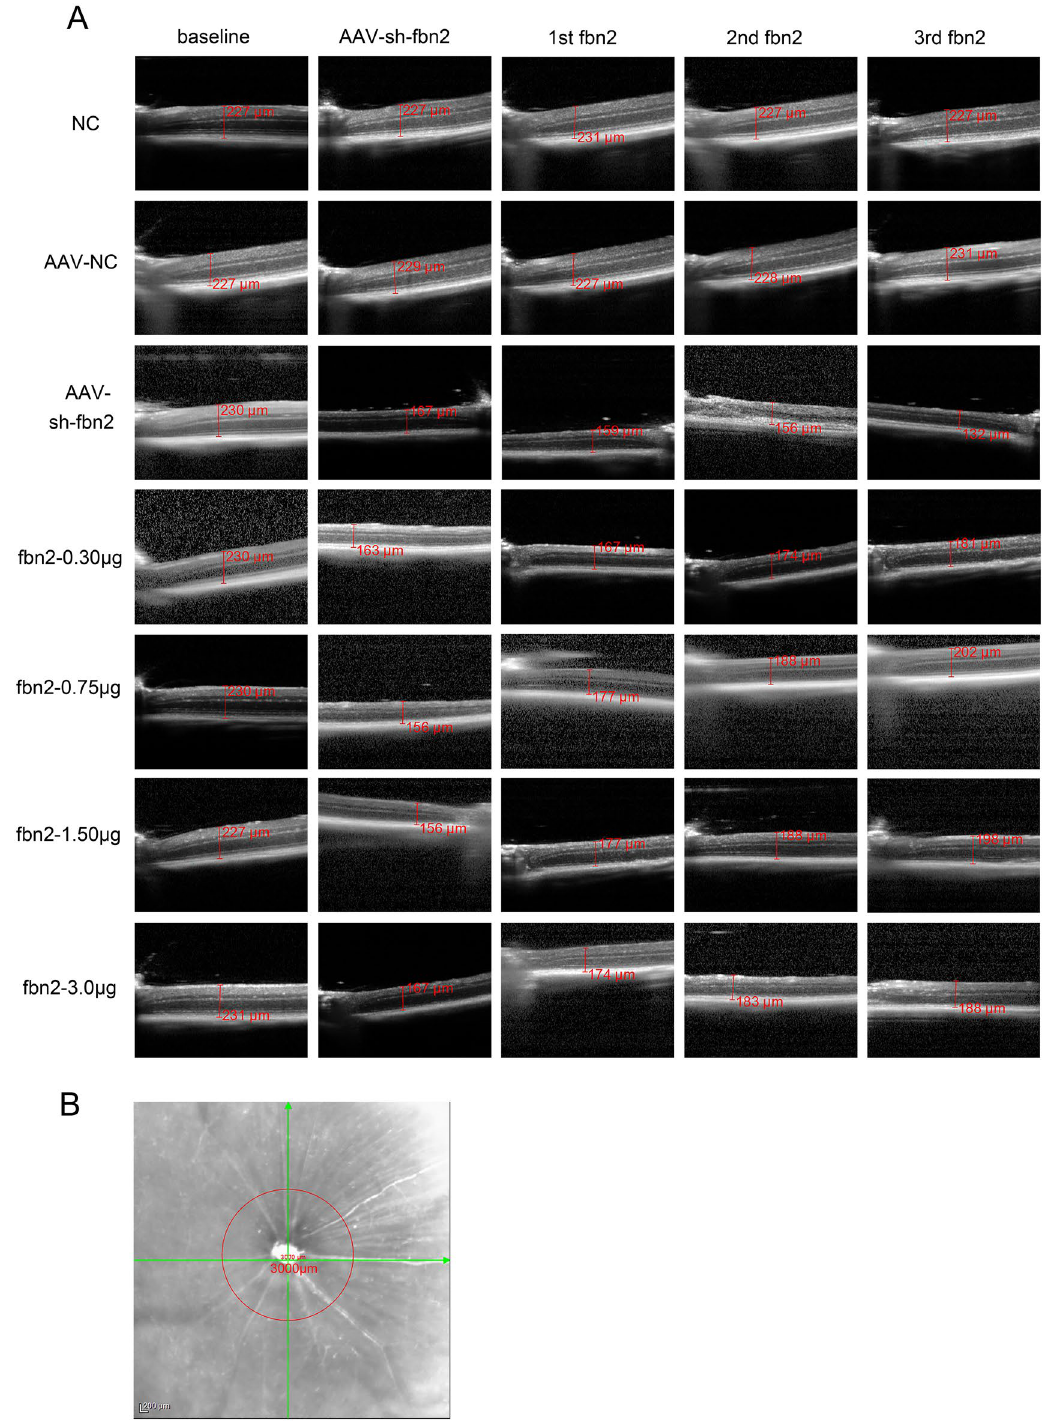
Figure 4. Retinal thickness imaging captured by OCT in NC, AAV-NC, AAV-sh-fbn2, Fbn2-0.30 μg, Fbn2- 0.75 μg, Fbn2-1.50 μg and Fbn2-3.0 μg group mice. ( A ). Retinal thickness was measured at 3000 μm from optic disc (inferior, nasal, temporal, and superior) ( B ).NC group: Animals without intervention. AAV-NC group: Animals with an intravitreal injection of AAV empty vector and without any further treatment. AAV-sh-fbn2 group: Animals with an intravitreal injection of AAV-sh-fbn2 and without any further treatment. Fbn2-0.30 μg group: Animals with an intravitreal injection of AAV-sh-fbn2, followed by an intravitreal injection of fbn2 recombinant protein in a dose of 0.30 μg. Fbn2-0.75 μg group: Animals with an intravitreal injection of AAV-sh- fbn2, followed by an intravitreal injection of fbn2 recombinant protein in a dose of 0.75 μg. Fbn2-1.5 μg group: Animals with an intravitreal injection of AAV-sh-fbn2, followed by an intravitreal injection of fbn2 recombinant protein in a dose of 1.50 μg. Fbn2-3.0 μg group: Animals with an intravitreal injection of AAV-sh-fbn2, followed by an intravitreal injection of fbn2 recombinant protein in a dose of 3.00